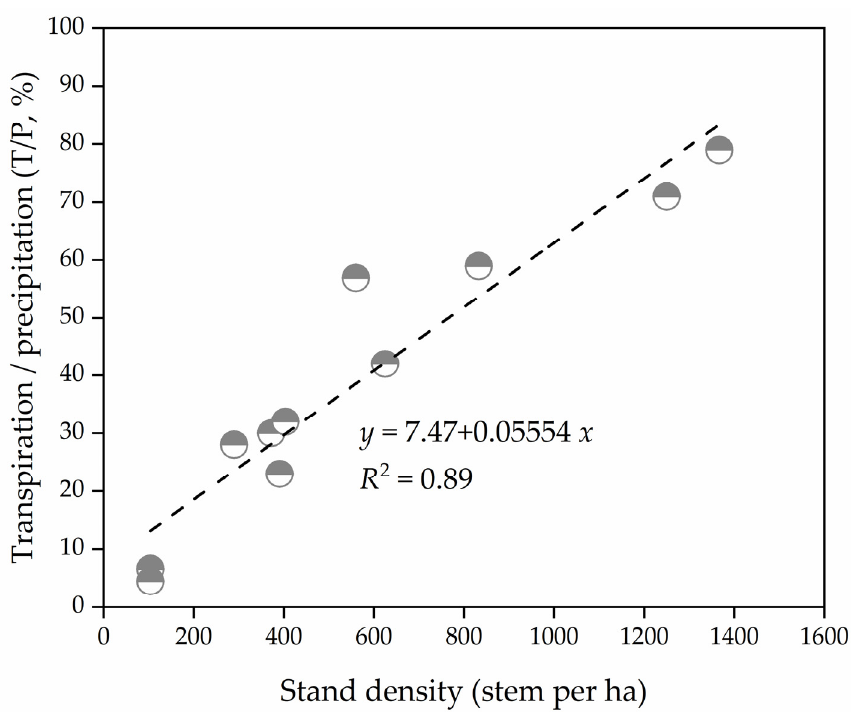
Figure 3. Relationship between the percentage of transpiration to annual precipitation (T/P) and the stand density of Mongolian Scots pines plantations. Data collected from reports on study sites in Horqin Sandy Land, northern China